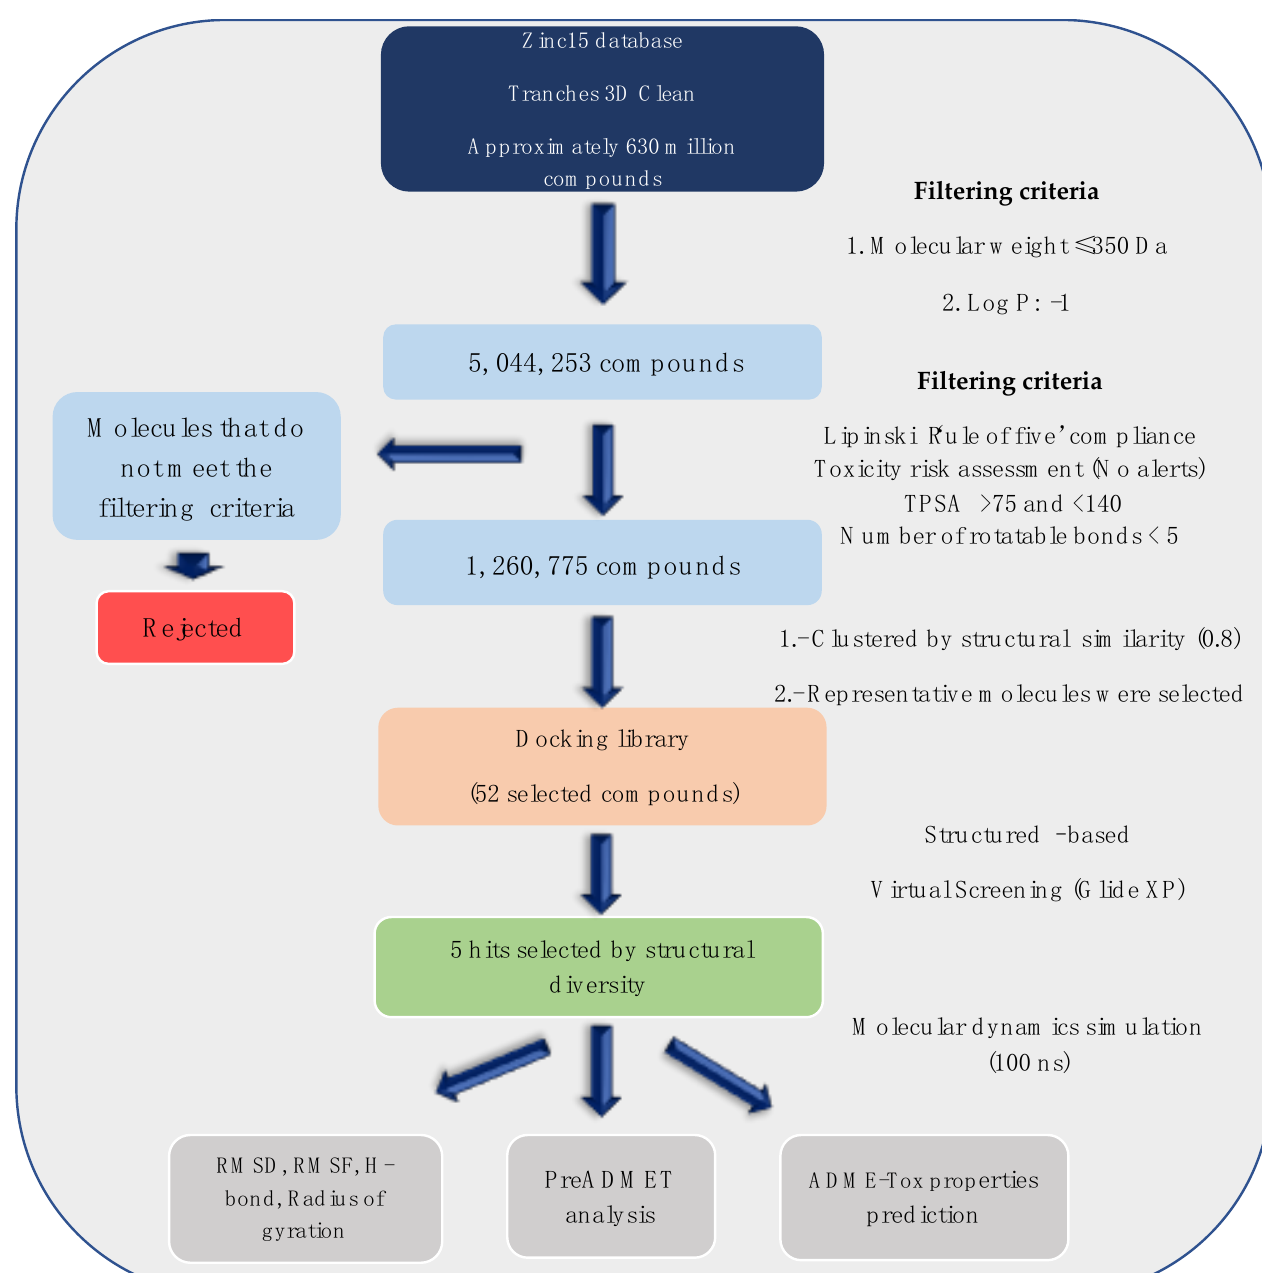
Figure 1. Workflow to select the potential SaSK inhibitors by computer-assisted drug design.